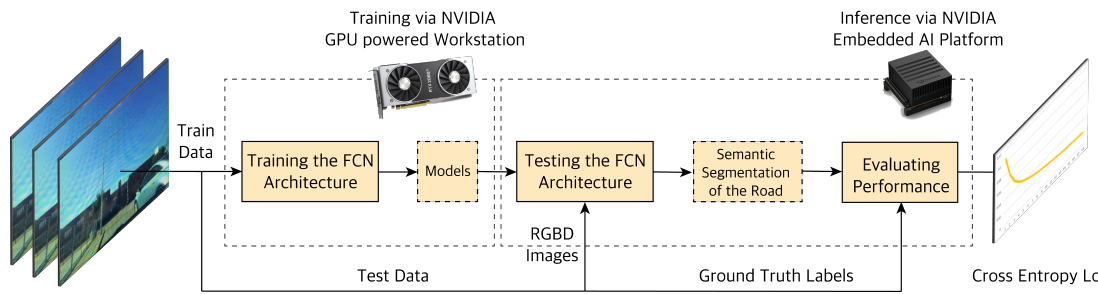
Figure 12. Overview of the experiment process. Training a Deep Neural Network model requires powerful computing resources; hence, for training we use a GPU powered workstation. Inference is less computationally expensive; thus, when the model is trained, we use an embedded GPU enabled device for testing and inference at the edge